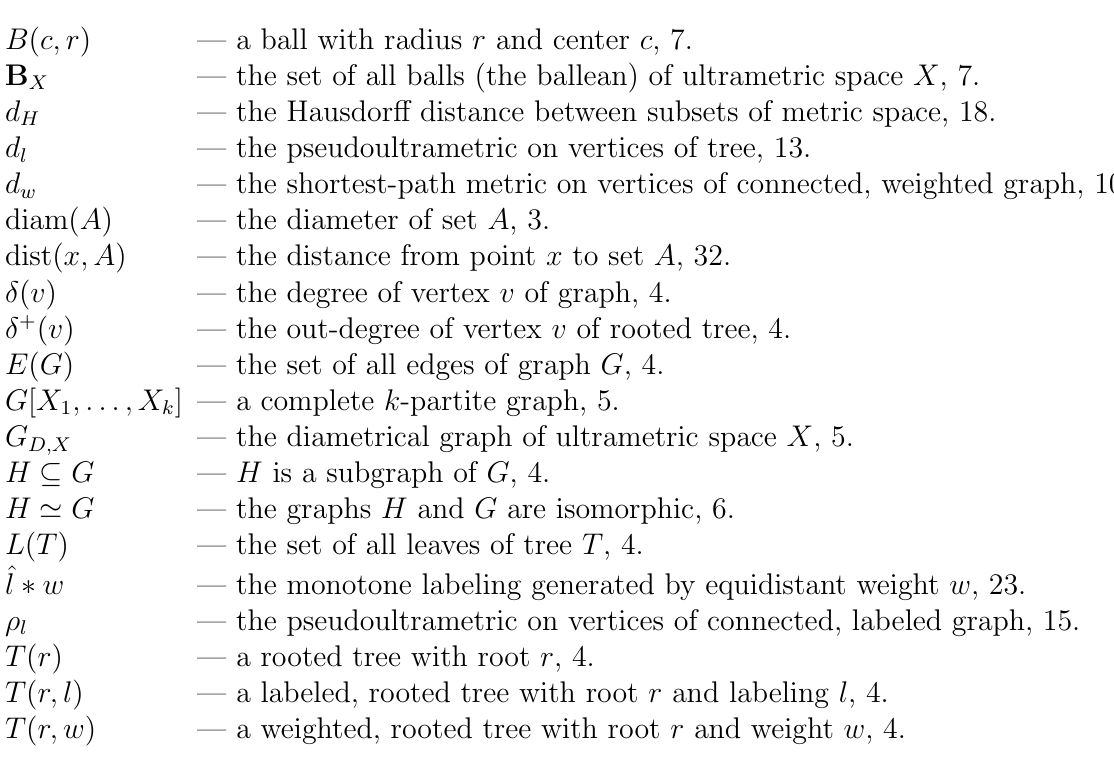
Table of notation and